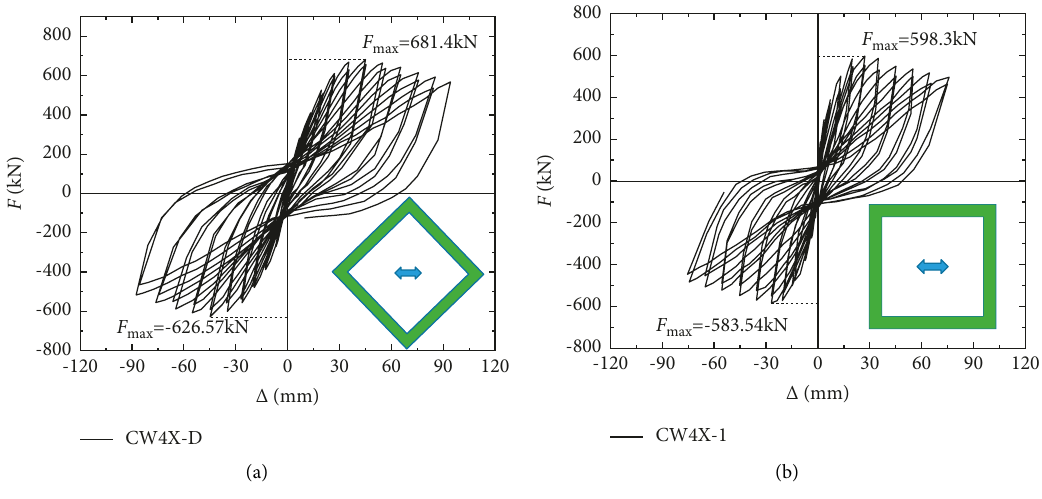
Figure 8: Hysteretic curves. (a) CW4X-D. (b)